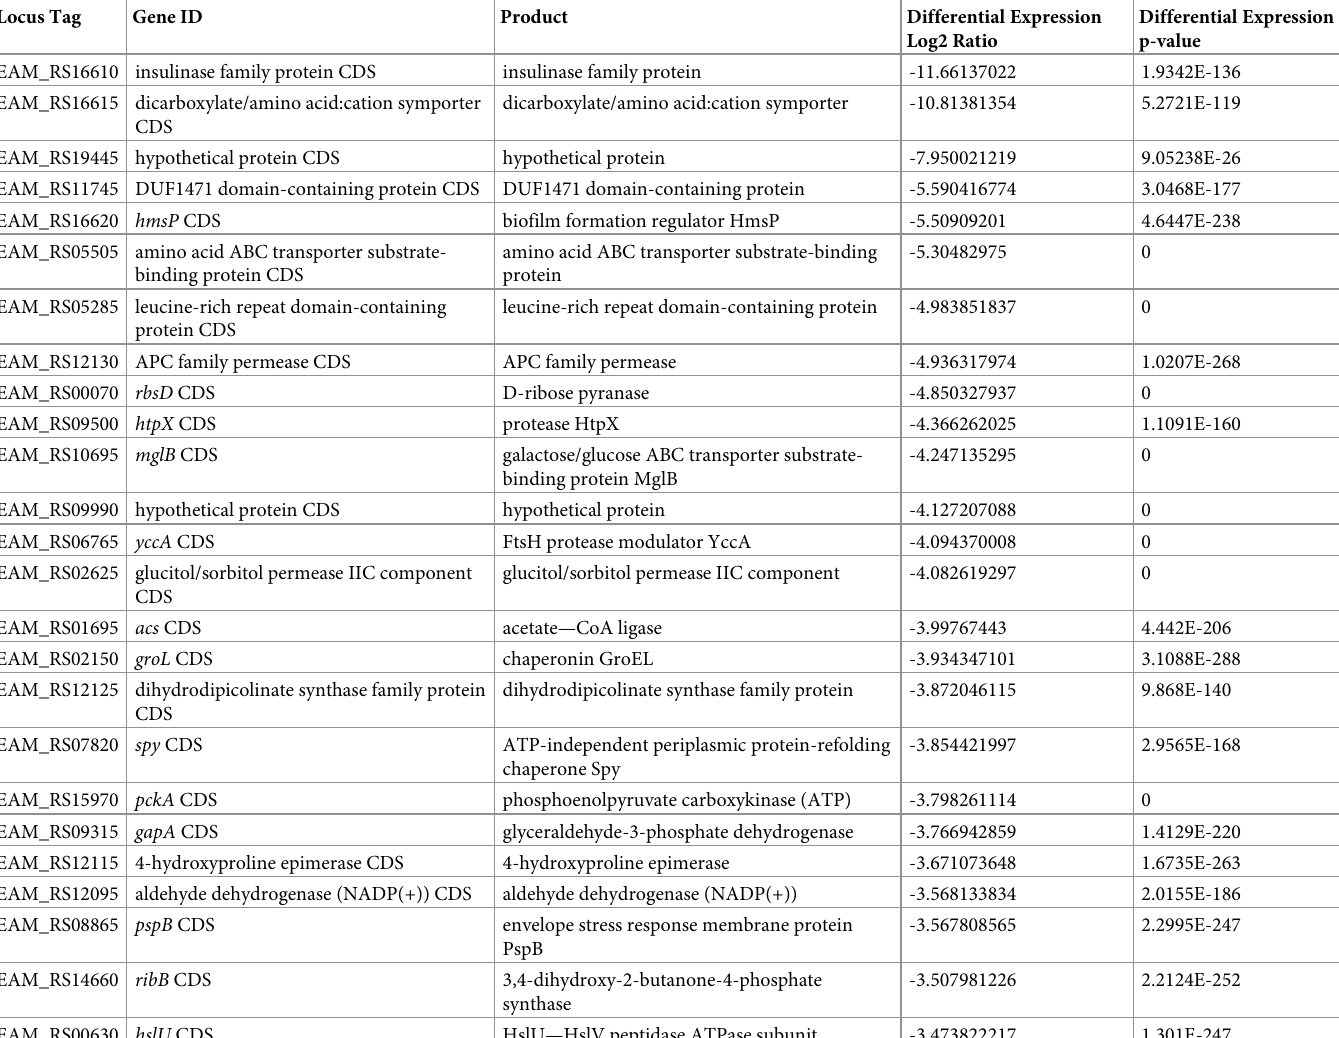
Table 1. A list of the 25 most negatively regulated genes in Ea1189 Δ 12 relative to WT Ea1189. Locus